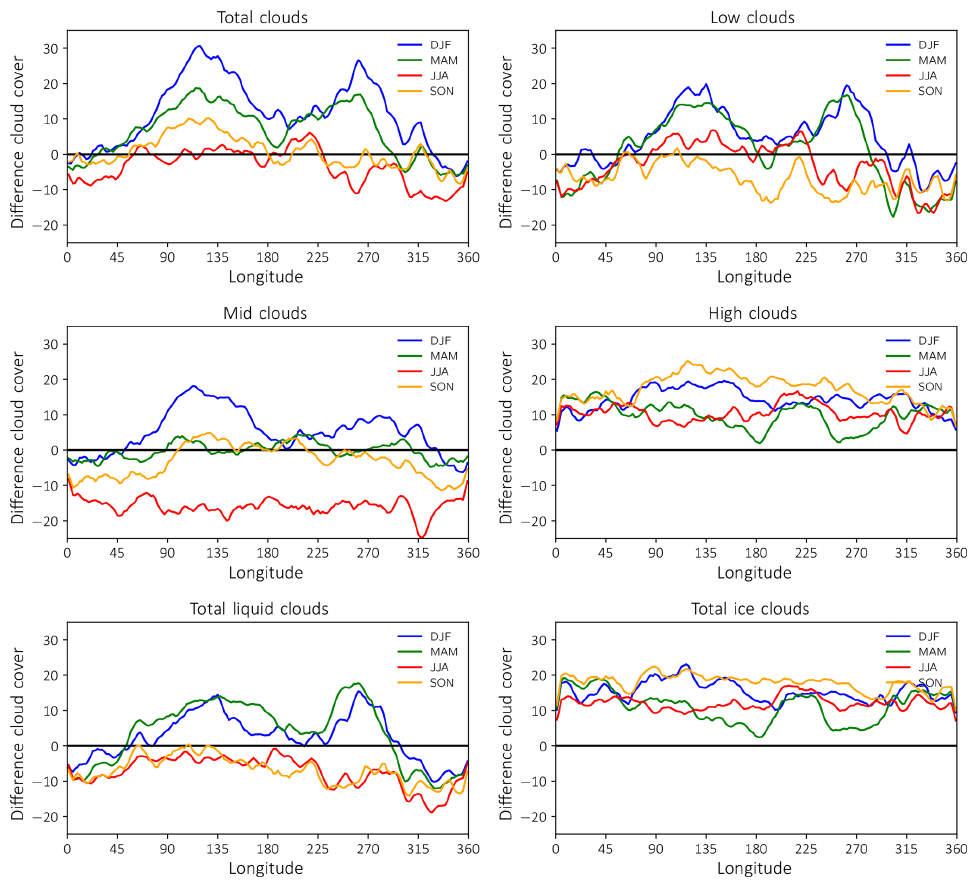
Figure 3. Meridional mean (60 to 82 ◦ N) difference in cloud cover (model minus satellite) between ECHAM6 + COSP and CALIPSO for total, low, mid, and high clouds as well as difference in total liquid and total ice cloud